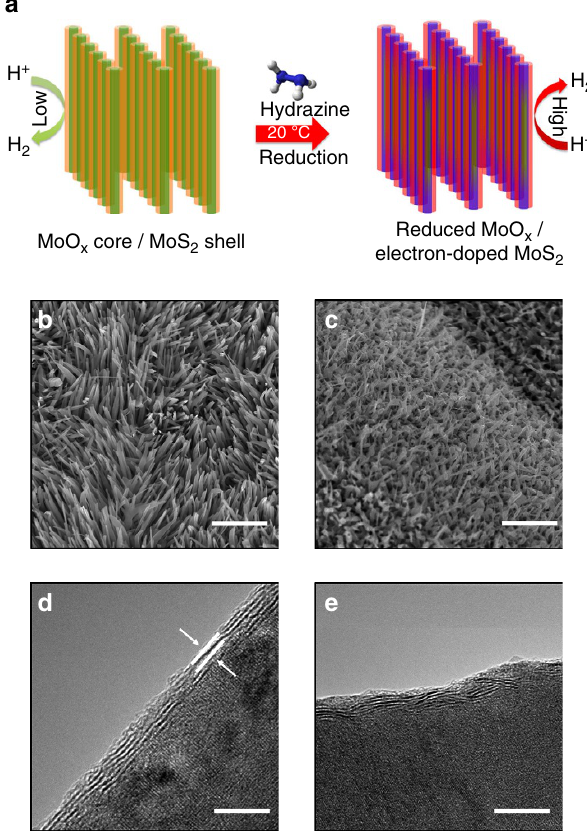
Figure 1 | Schematic representation of hydrazine treatment and microscopic analysis of MoO x /MoS 2 core-shell nanowires. ( a ) Schematic representation of exposure of MoO x /MoS 2 core-shell nanowire array to dilute hydrazine under ambient conditions. ( b ) SEM image of as-grown MoO x /MoS 2 core-shell nanowire array. Scale bar, 2 m m. ( c ) SEM imaging MoO x /MoS 2 core-shell nanowires following dilute hydrazine treatment, showing that the overall nanowire morphology is maintained. Scale bar, 2 m m. ( d ) High-resolution TEM (HRTEM) of as-grown nanowire, showing thin ( B 3–5nm) MoS 2 shell on a single crystal MoO x core. The MoS 2 has the typical interlayer spacing of 6.2Å, denoted in image by two parallel lines. Scale bar, 5nm. ( e ) HRTEM of the MoO x /MoS 2 core-shell nanowire after exposure to hydrazine. Scale bar,